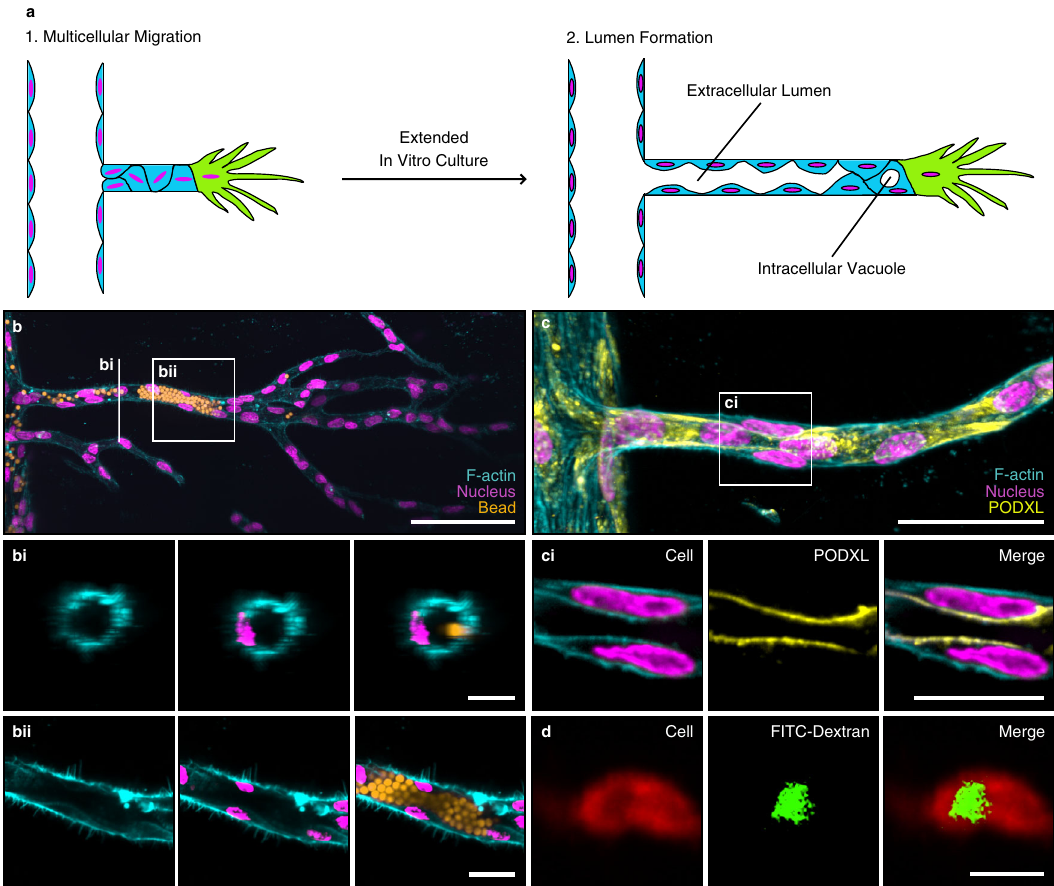
Fig. 2 Vascular lumen formation can be achieved in synthetic hydrogels. a Schematic of vascular lumen formation consisting of two consecutive steps: multicellular migration of HUVECs is followed by lumen formation. b Lumen formation in dextran vinyl sulfone (DexVS) hydrogels. Visualization of lumens by perfusion with 4 μ m diameter fl uorescent beads (yellow) added from the parent channel to enter the sprouts (scale bar, 100 μ m), b i Vertical section of the 3D sprout (scale bar, 20 μ m), b ii Horizontal section of the 3D sprout (scale bar, 20 μ m). c Expression of the luminal marker podocalyxin (PODXL, yellow) showed the formation of intercellular lumens (scale bar, 50 μ m), c i Horizontal section of the lumen (scale bar, 20 μ m). d Visualization of intracellular vacuole formation by pinocytosis of FITC-dextran. FITC-dextran MW 3000 – 5000 Da was added in both channels for 10 days (scale bar, 20 μ m). All samples contained 12 mM immobilized CGRGDS and 25.2mM NCD crosslinker. Composite fl uorescence images of 3D projections showing F-actin (cyan) and nuclei